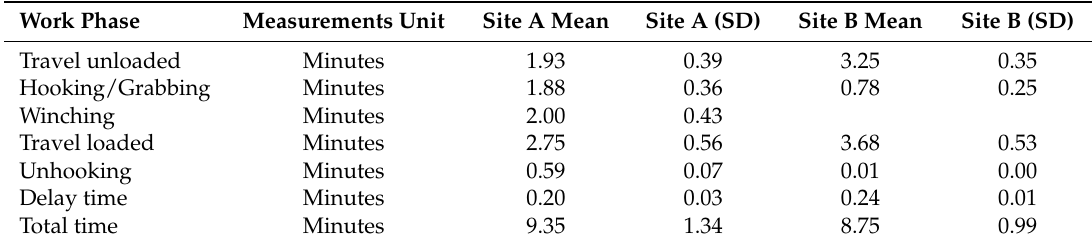
Table 4. Descriptive statistics of the mean value and standard deviation (SD) at sites A and B.